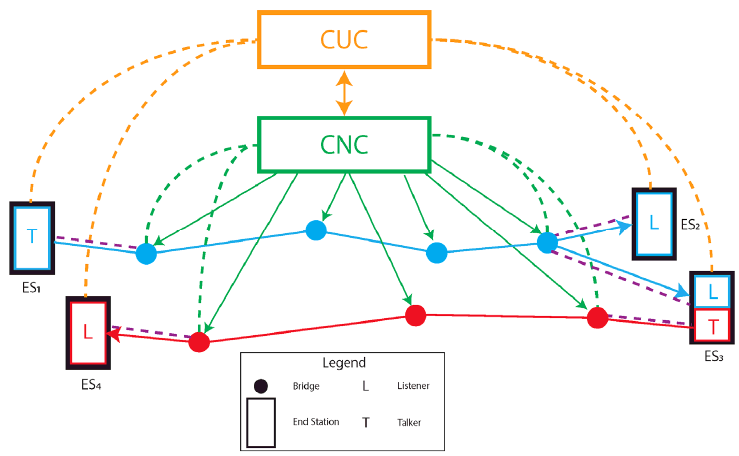
Figure 5. A simple network